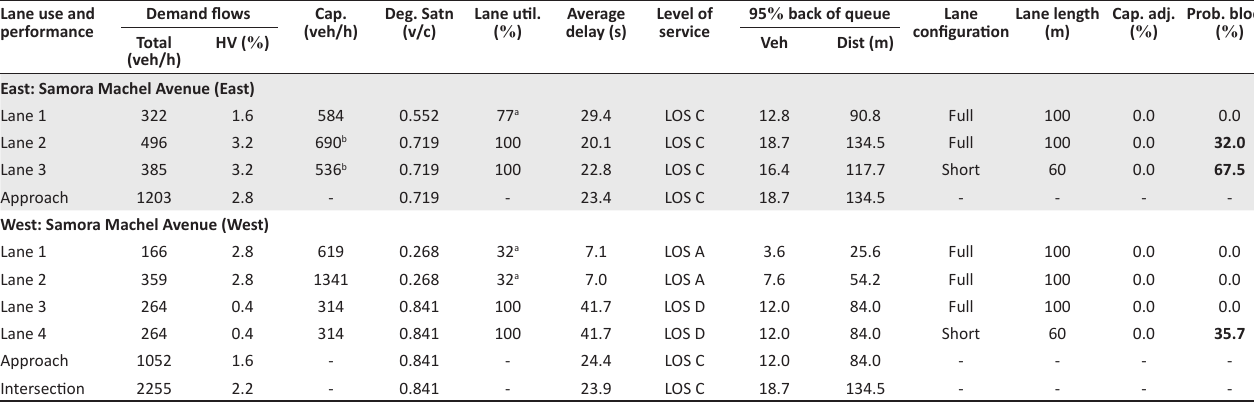
FIGURE 6: Weekday oversaturated traffic conditions and driver behaviour on Samora Machel Avenue and Chinhoyi Street in Harare from 17:00 to 18:00. TABLE 3: Intersection operational performance